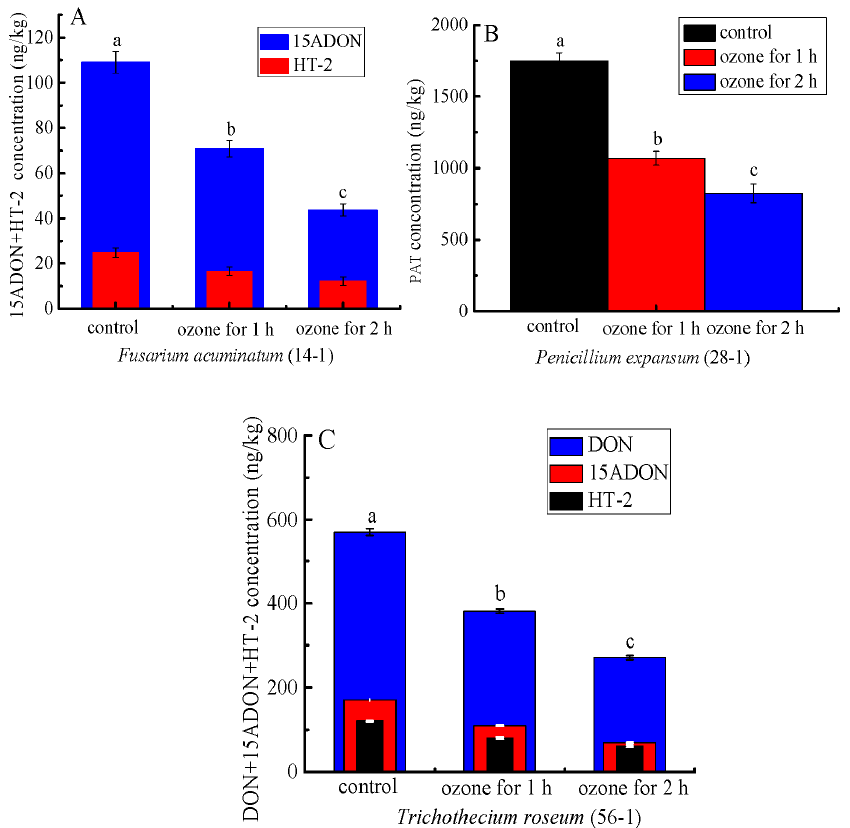
Figure 9. The effect of ozone treatment on mycotoxin accumulation of fresh C. pilosula infected by the isolates at 56 days of storage. ( A ) 15ADON and HT-2 toxin for Fusarium acuminatum (14-1); ( B ) Patulin (PAT) for Penicillum expansum (28-1); ( C ) DON, 15ADON, and HT-2 toxin for Trichothecium roseum (56-1); The different letters indicate significant differences during the same storage period ( p < 0.05).